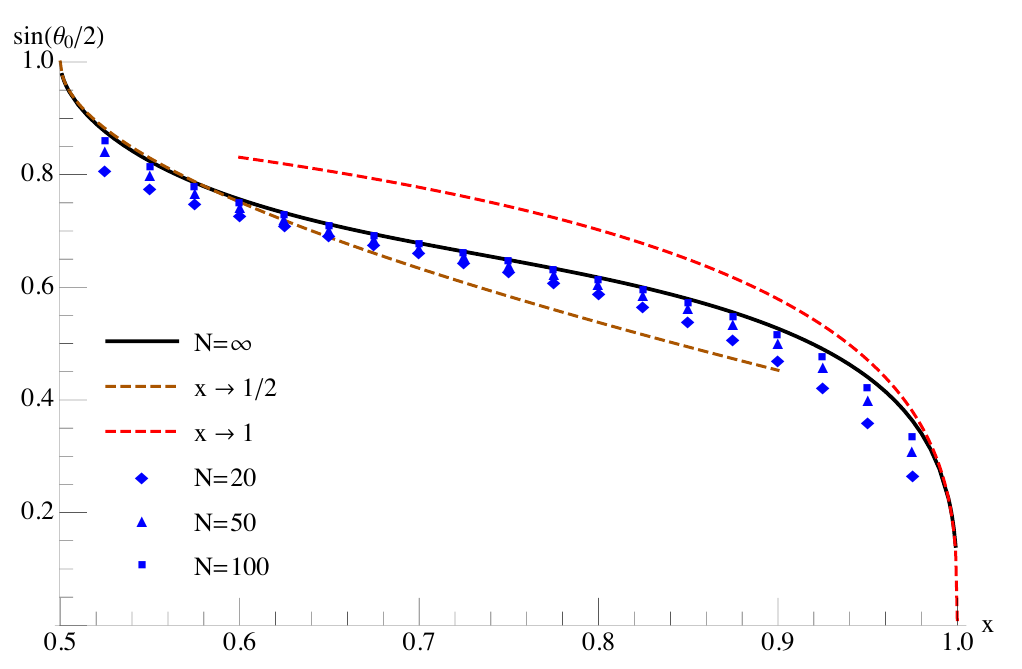
Figure 2 . Temperature dependence of the phase gap # 0 ( x ). The black central curve is the result of the N = 1 algorithm keeping K = 34 modes. The blue symbols show the (cid:12)nite N results at N = 20 ; 50 ; 100 from the solution of (2.1). The dashed brown and red curves are the analytical approximations in